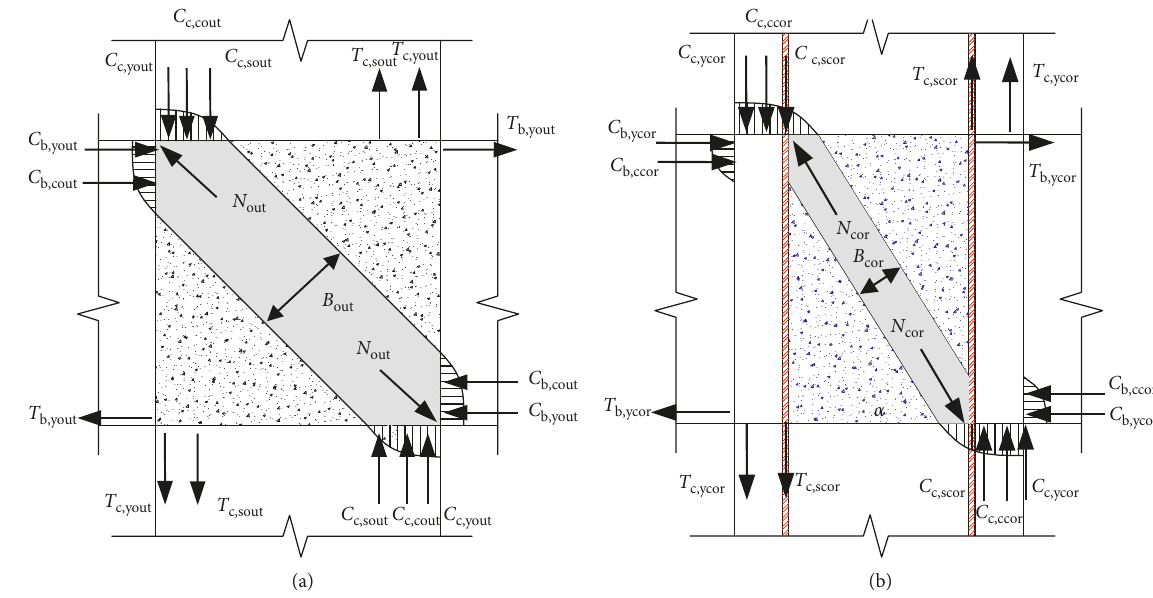
Figure 12: Shear mechanism of the concrete inclined column. (a) Concrete outside the tube. (b) Concrete inside the